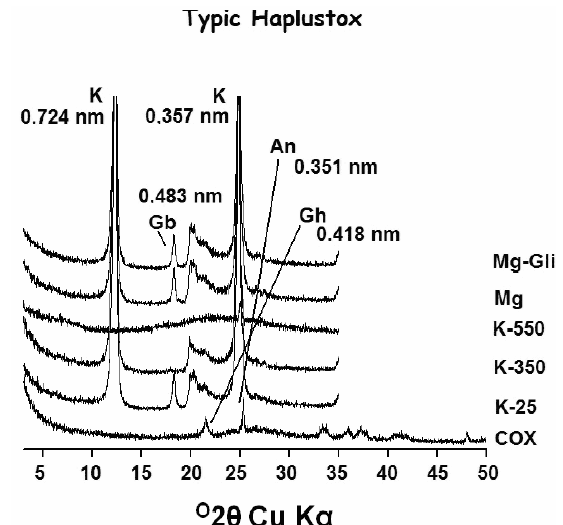
Figure 4. X ray diffractograms of the deferrified clay fraction and oxide concentrations in the Bw horizon of the Red Yellow Latosol (LVA). K: Kaolinite, Gb: Gibbsite, Gh: Goethite, and An: